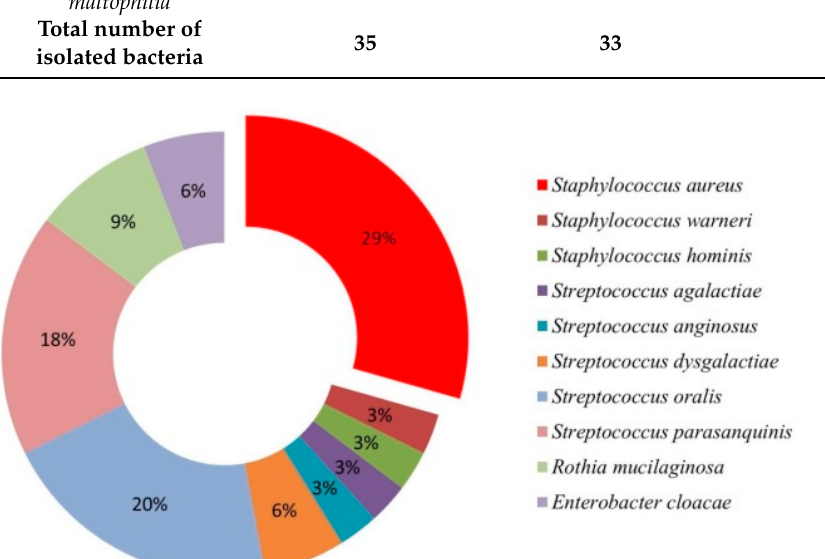
Figure 1. Percentage representation of species in postoperative samples of palatine tonsil tissue of Group I patients.